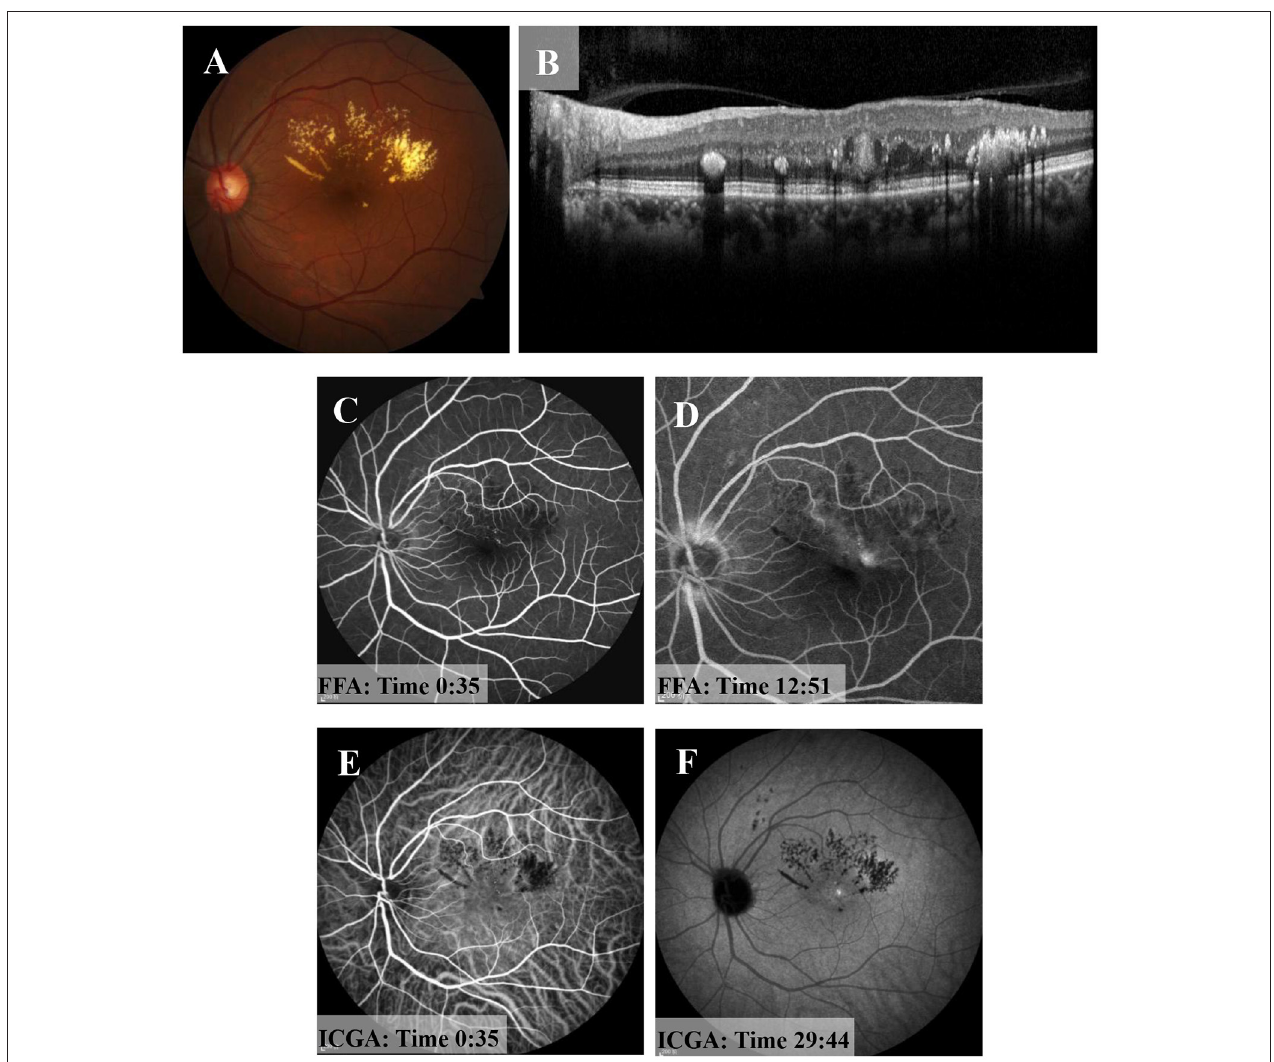
FIGURE 3 | One month after the second MPL treatment. (A) Fundus examination of the left eye shows muddy-like exudation above the macular area and that the off-white lesions had shrunken. (B) OCT shows that the oval structure in macular area had become more solid and that the cavity structure had disappeared. (C,D) FFA shows strong fluorescent light spots near the macular area in the early stage and slight leakage in the later stage. (E,F) ICGA shows a light spot near macular area in the early stage, and there was no leakage in the later